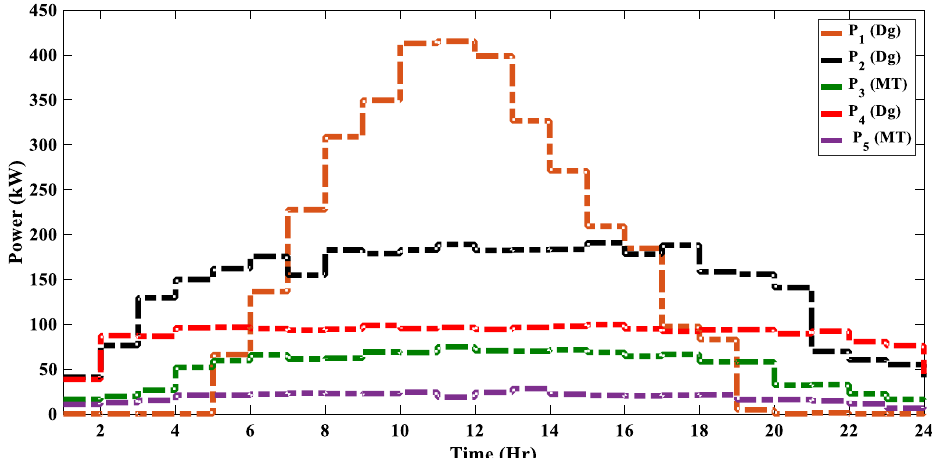
Figure 6. The generation scheduling of MSCHPEED for emission minimization.